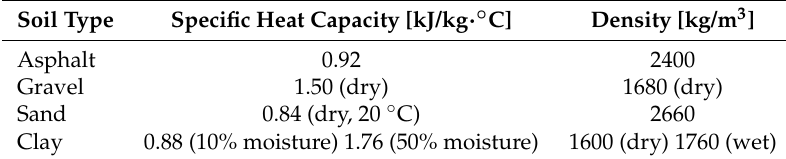
Table 2. Some physical properties of the soil in the literature